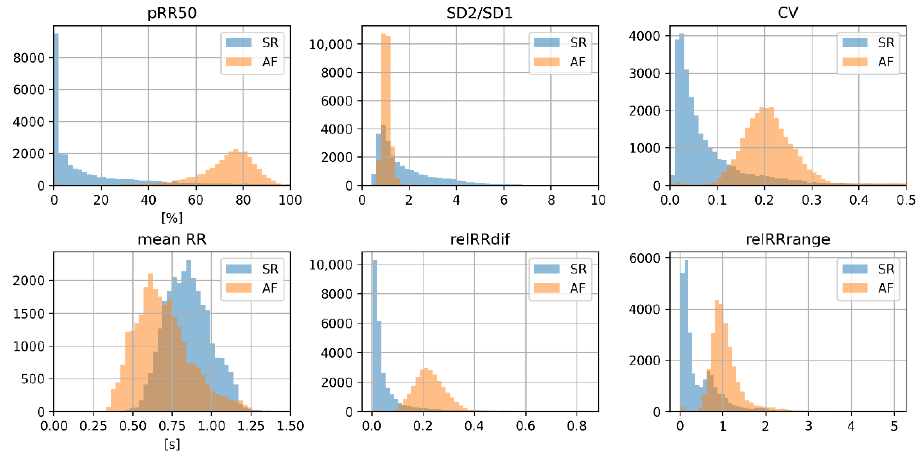
Figure 3. Histograms of six heart rate variability parameters with the highest score from minimum redundancy maximum relevance algorithm (blue — sinus rhythm, SR; orange — atrial fibrillation, AF). pRR50 — percentage of successive differences between RR intervals greater or equal to 50 ms; SD1 and SD2 — standard deviation of points in the Poincare plot across and along the identity line,